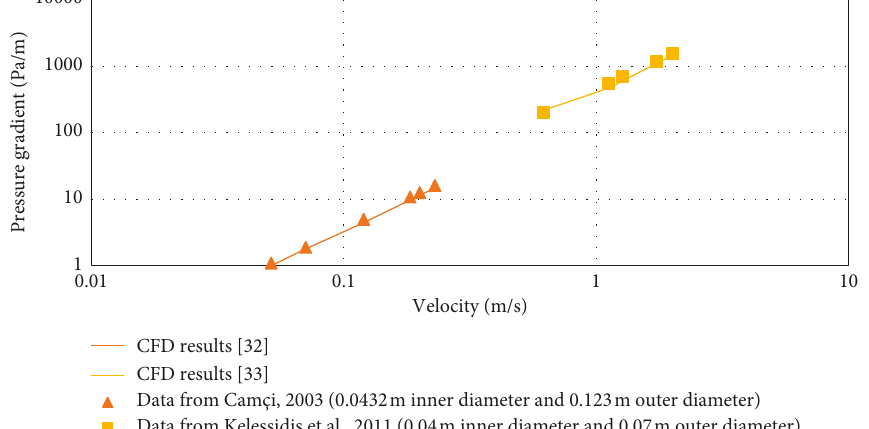
Figure 7: Comparison of simulated pressure gradient with experimental data from Kelessidis et al. (2011) and Camçi (2003) at different inlet